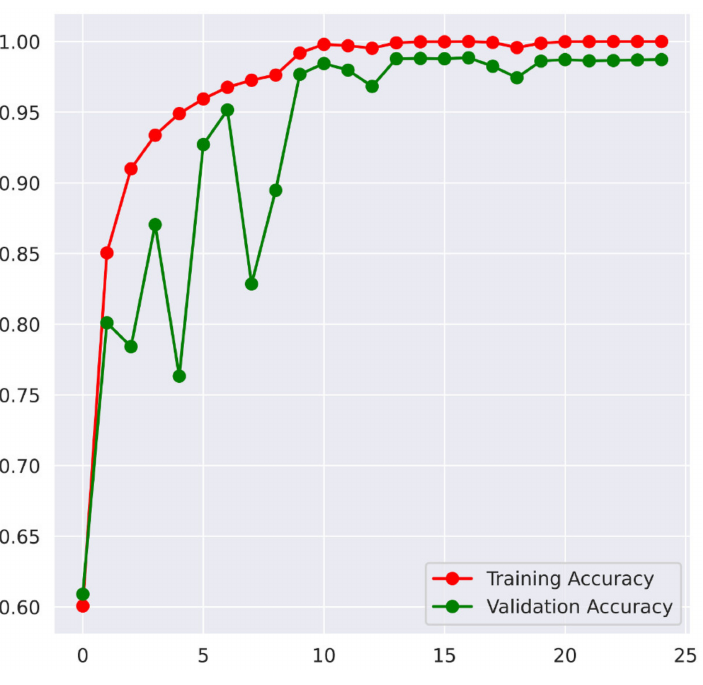
Figure 10. Accuracy graph for training and testing for